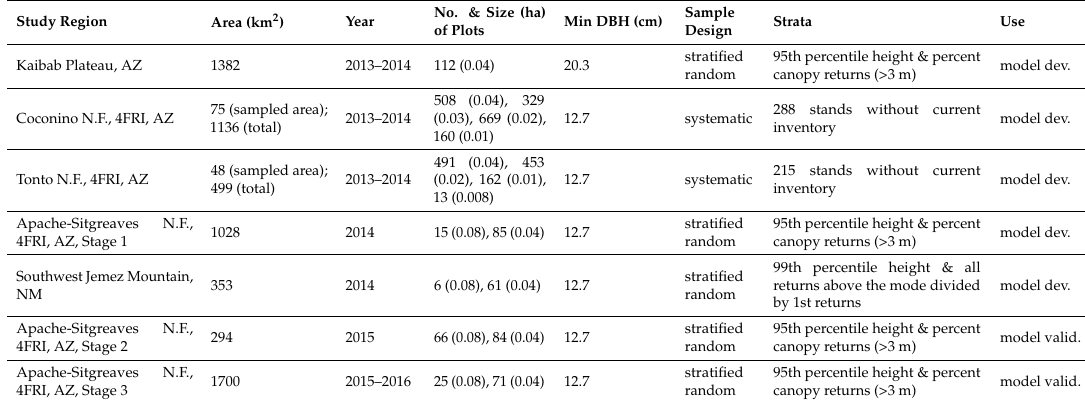
Table 1. Data collection summary for each project.